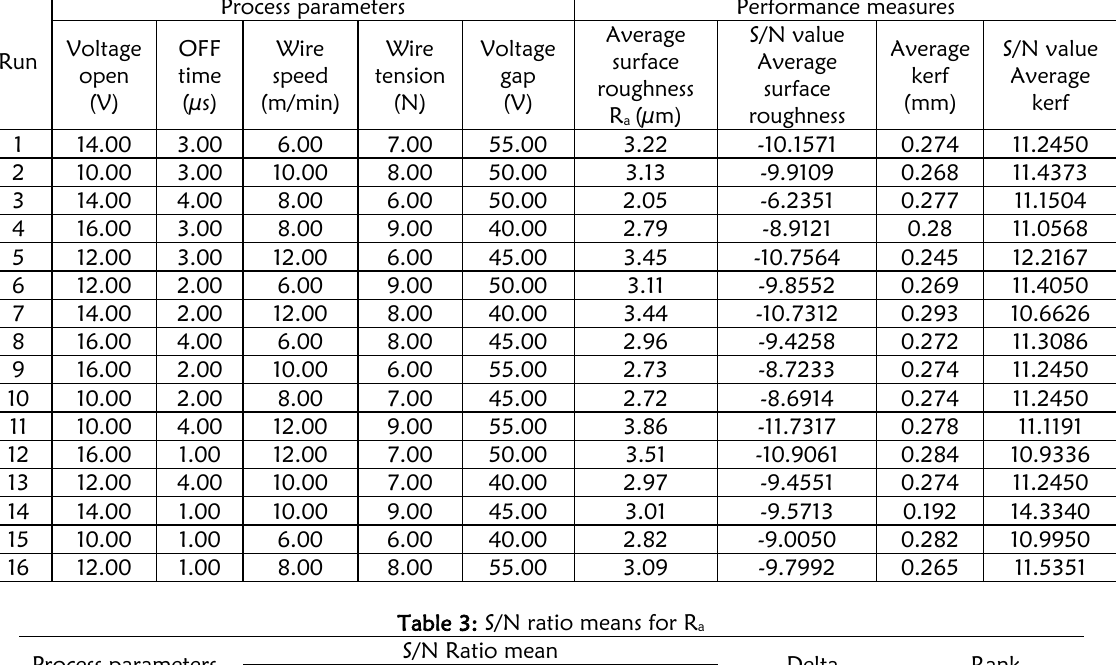
Table 2: Experimental result for average surface roughness and average kerf